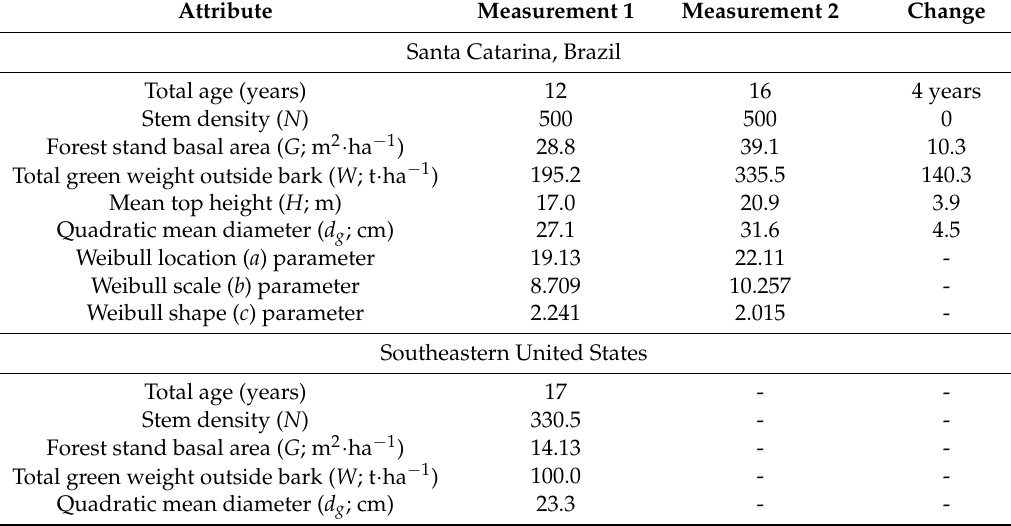
Table 1. Population parameters of thinned plantations of loblolly pine in Brazil and the United States used in this analysis. Attribute Measurement 1 Measurement 2